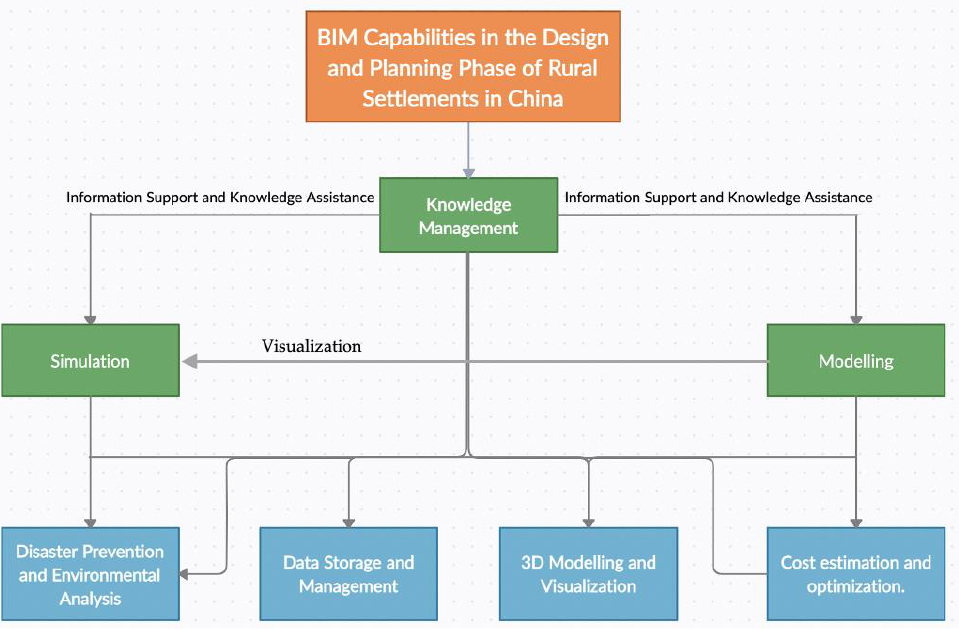
Figure 5. The relationship of different BIM capabilities in the design and planning phase of rural settlements.